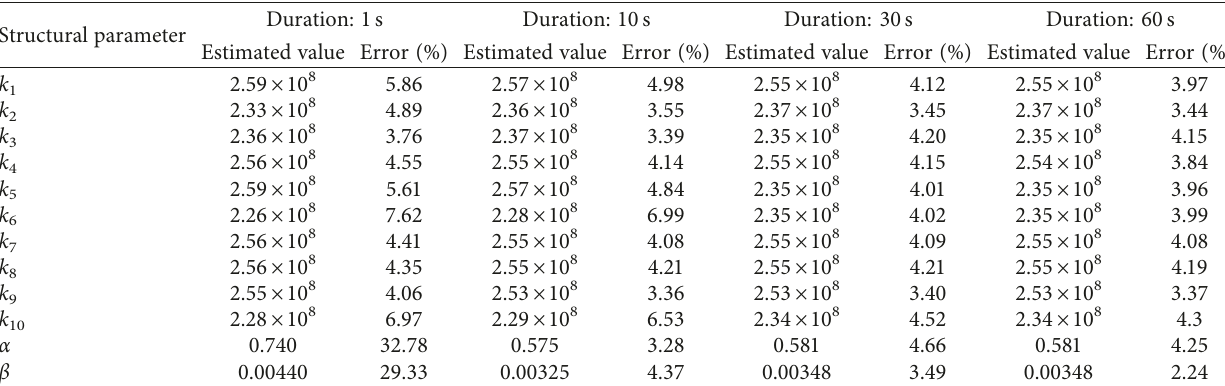
Table 5: Structural parameter estimation results under different sampling durations.